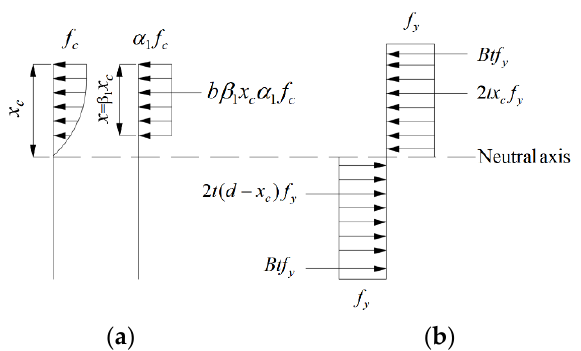
Figure 15. The stress blocks of the specimen: ( a ) Concrete; ( b ) Steel.